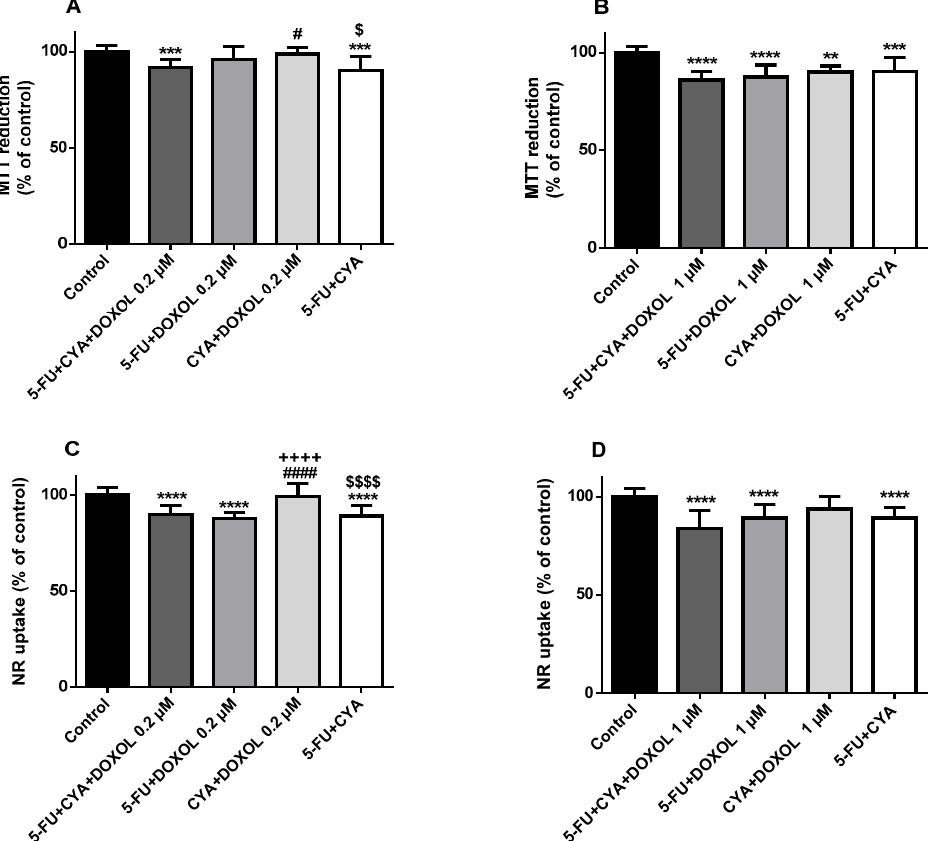
Figure 6. Cytotoxicity evaluated by ( A , B ) the MTT reduction assay and ( C , D ) the NR uptake assay in differentiated H9c2 cells incubated for 48 h with 5-FU + DOXOL + CYA: 5-FU at 50 μ M, DOXOL (0.2 or 1 μ M) and CYA at 50 μ M. Results are presented as mean ± SD of three to four independent experiments (total of 10–20 wells). Statistical analyses were performed using the Kruskal–Wallis test, followed by the Dunn´s post hoc test ( A,B,D ) or the ANOVA test, followed by the Tukey’s post hoc test ( C ) (** p < 0.01, *** p < 0.001, **** p < 0.0001 vs. control; # p < 0.05, #### p < 0.0001 vs. 5-FU + CYA + DOXOL 0.2 μ M; ++++ p < 0.0001 vs. 5-FU + DOXOL 0.2 μ M; $ p < 0.05, $$$$ p < 0.0001 vs. CYA + DOXOL 0.2